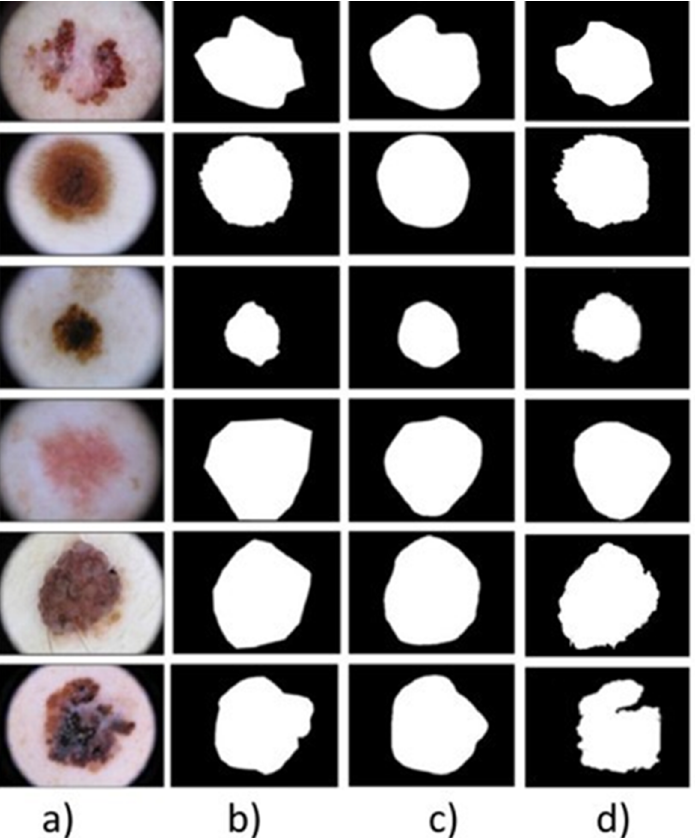
Figure 9. The visual projections derived from the ISIC 2018 image dataset. ( a ) The original image from the dataset. ( b ) The given binary mark (ground truth), ( c ) The prediction effects of the proposed method (Att U-Net + GN). ( d ) The results of our RL algorithm. Our algorithm is able to segment the lesions clearly. However, in some cases, it shows exactly the lesion shape in the segmentation mask, deviating a bit from the ground truth. However, as can be seen, the segmentation masks are clear.